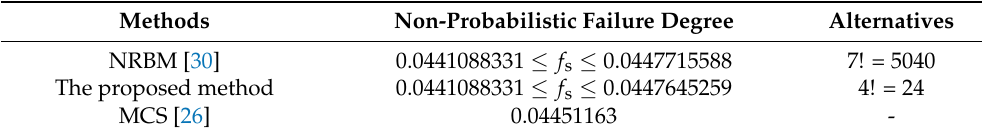
Table 6. Reliability analysis results for numerical example